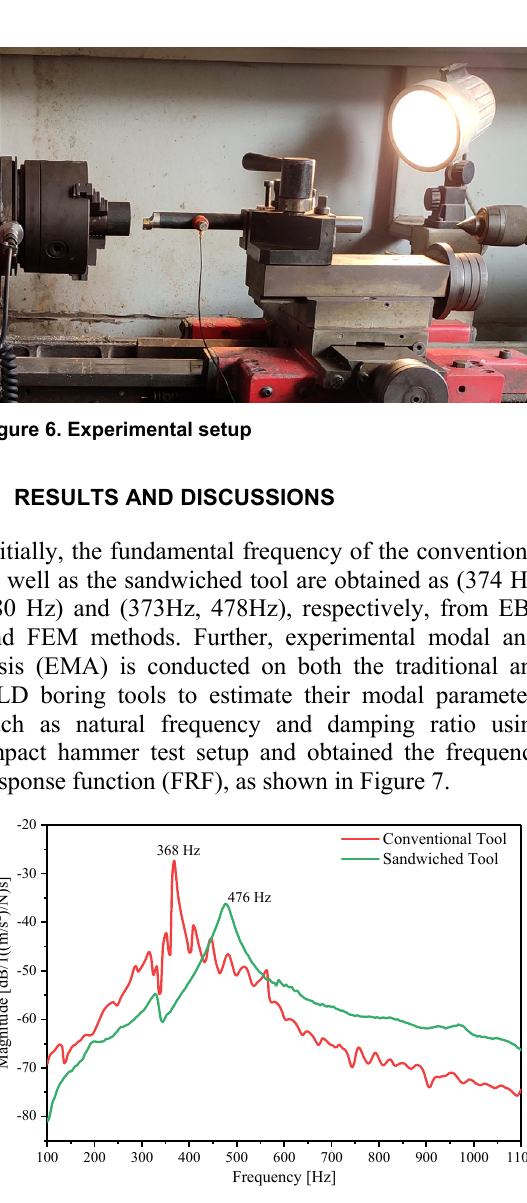
Figure 7. Frequency response plot for conventional and CLD boring bar